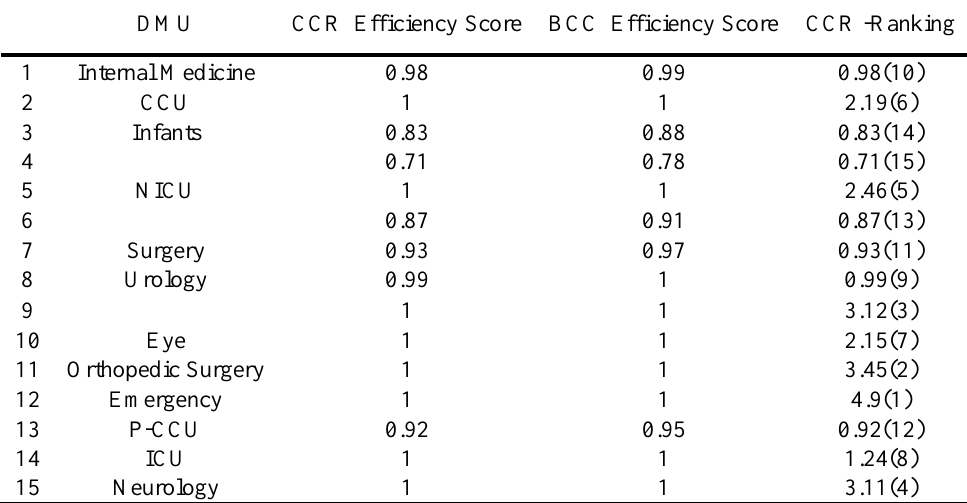
Table 8. Efficiency score and ranking in case study application in year